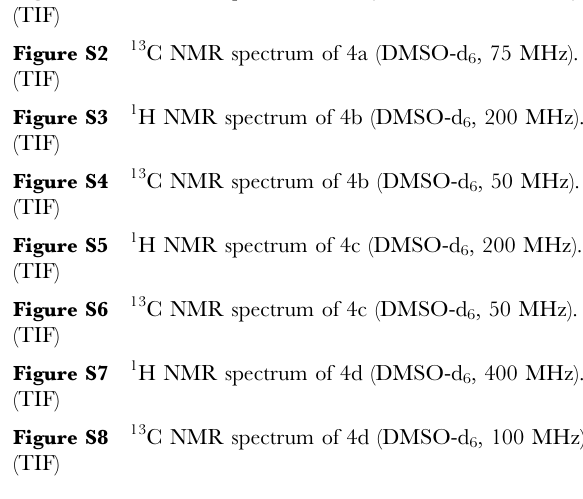
Figure S9 1 H NMR spectrum of 4e (DMSO-d 6 , 200 MHz). (TIF) Figure S10 13 C NMR spectrum of 4e (DMSO-d 6 , 50 MHz). (TIF) Figure S11 1 H NMR spectrum of 4f (DMSO-d 6 , 200 MHz). (TIF) Figure S12 1 H NMR spectrum of 4 g (DMSO-d 6 , 300 MHz, t , 40 u C). (TIF) Figure S13 1 H NMR spectrum of 4 g (DMSO-d 6 , 300 MHz, t , 90 u C). (TIF) Figure S14 1D NOESY spectrum of 4 g (DMSO- 6 , 300 MHz). Irradiation at 11.48 ppm. (TIF) Figure S15 1D NOESY spectrum of 4 g (DMSO-d 6 , 300 MHz). Irradiation at 8.26 ppm. (TIF) Figure S16 13 C NMR spectrum of 4 g (DMSO-d 6 , 75 MHz). (TIF) Figure S17 1 H NMR spectrum of 9 (DMSO-d 6 , 200 MHz, t , 40 u C). (TIF) Figure S18 1 H NMR spectrum of 9 (DMSO-d 6 , 300 MHz, t , 90 u C). (TIF) Figure S19 1 H NMR spectrum of 4 h (DMSO-d 6 , 400 MHz). (TIF) Figure S20 1 H NMR spectrum of 15 (DMSO-d 6 , 200 MHz). (TIF) Figure S21 13 C NMR spectrum of 15 (DMSO-d 6 , 50 MHz). (TIF) Figure S22 Chromatogram of compound 4 g obtained from reversed-phase HPLC studies. (TIF) Figure S23 1D NOESY spectrum of ( E )- N ’-benzylidene-2-(3- tert - butyl-1-phenyl-1 H -pyrazol-5-ylamino)acetohydrazide (4 g) in DMSO-d 6 (300 MHz). Irradiation at 11.48 ppm (A) and 8.26 ppm (B). Table S1 p38 a MAPK inhibitory activity of compounds (4a–g) at 10 m